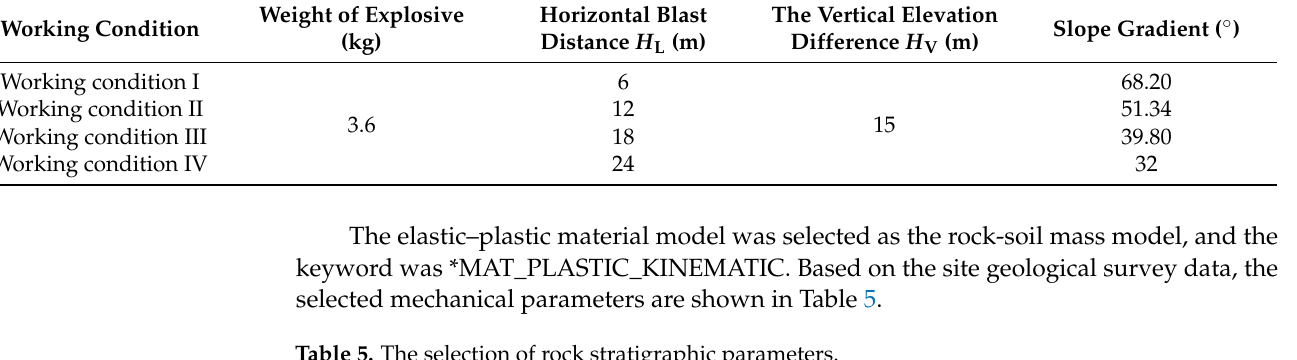
Table 5. The selection of rock stratigraphic parameters.